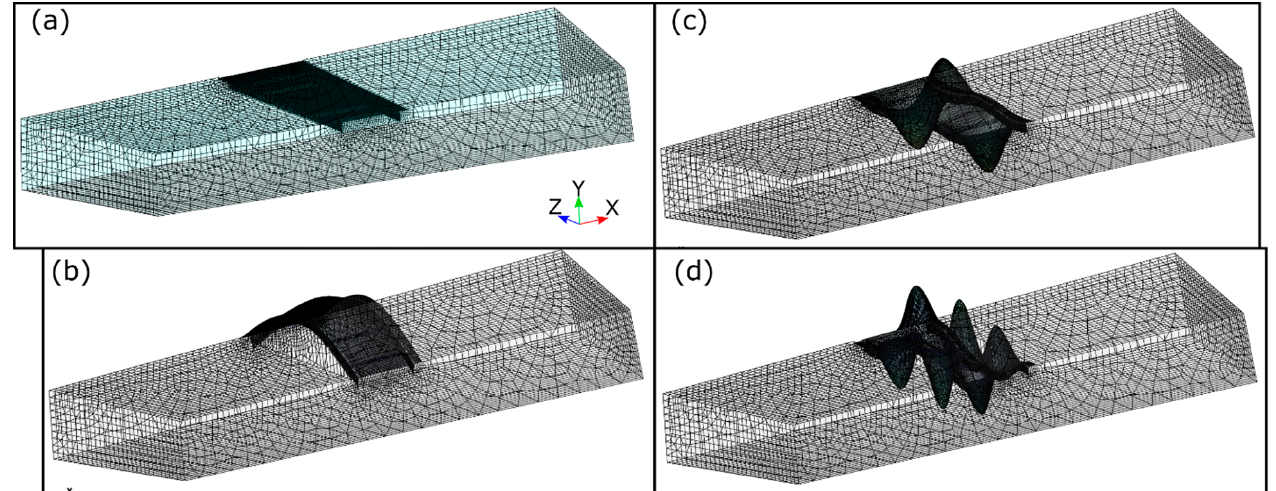
Figure 3. FEM of the small-scale bridge and its dominant modes in the semi-inundated condition: ( a ) undeformed FEM; ( b ) 1st mode shape; ( c ) 4th mode shape; ( d ) 17th mode